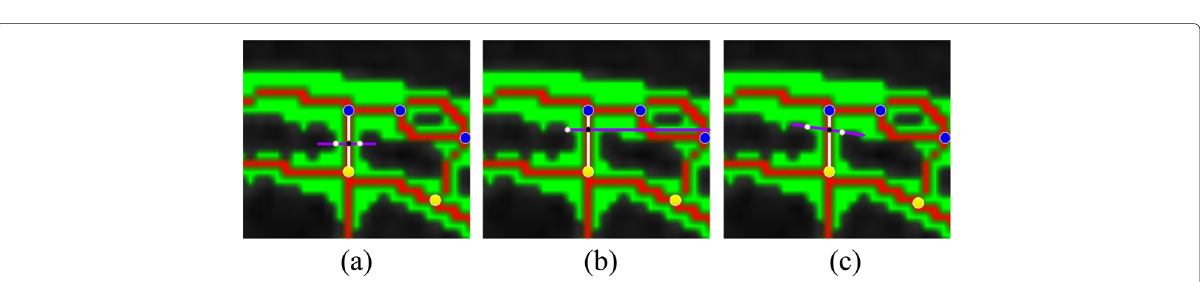
Fig. 10 The proposed cut strategy. a Construct a initial cut line at the middle of the white edge. b The cut line move close to the endplate until it touches the boundary of the endplate. c Reorient the cut line at an angle with minimal